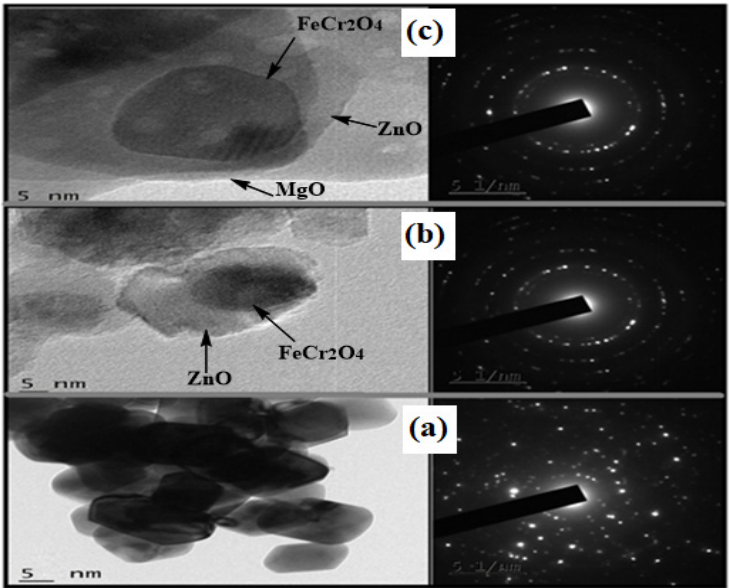
O @ZnO@MgO without UV 2 4